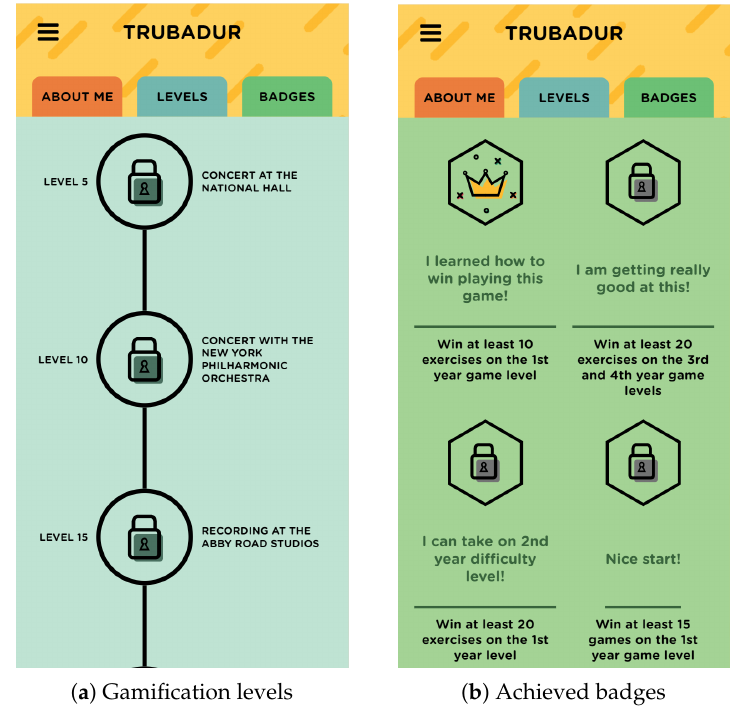
Figure 4. Gamification elements. The left screen shows progression between multiple badge levels of proficiency, while the right screen shows the badges obtained during the practice.